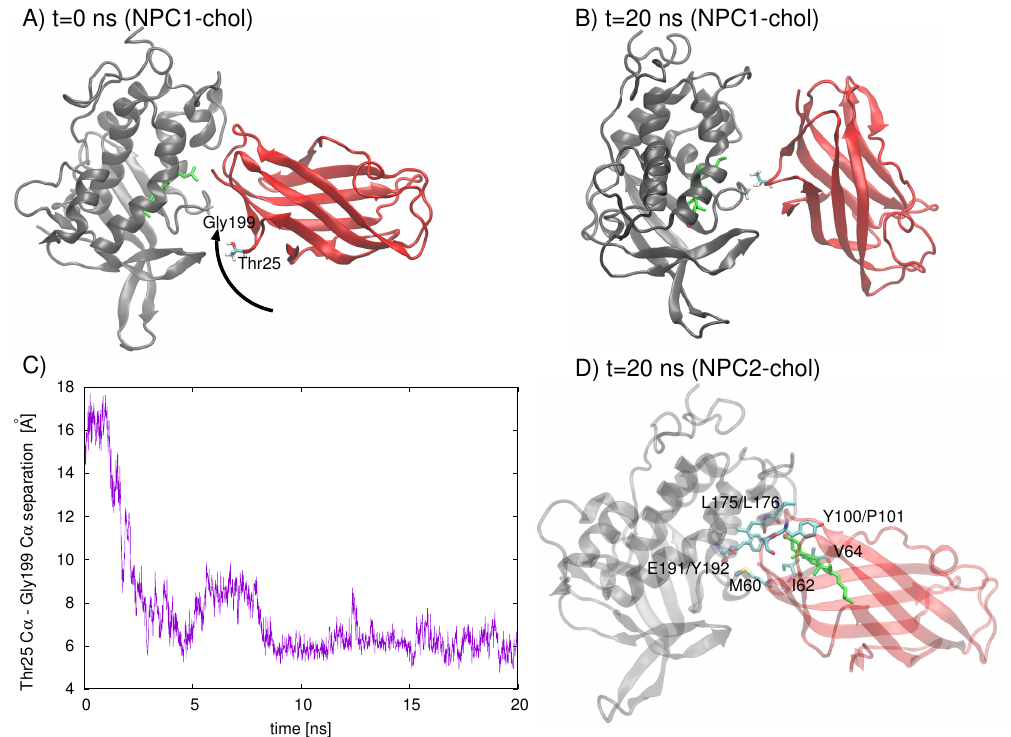
Figure 4. The relative orientation of the Texas model NPC1(NTD)-NP2 subunits with cholesterol in the NPC1 binding pocket (gray cartoon representation) at ( A ) t = 0 ns and ( B ) t = 20 ns highlights the rotation of the subunits with respect to each other. ( C ) The rotation brings two protruding loops, with Thr25 of NPC2 (red cartoon representation) and Gly199 of NPC1, into close proximity (Thr25 C α –Gly199C α decreases from ∼ 16 Å to ∼ 6 Å). ( D ) The relative orientation of the Texas model NPC1(NTD)-NP2 subunits (shown here in transparent cartoon representation for clarity) with cholesterol (green stick) in the NPC2 binding pocket at t = 20 ns preserves the interface interactions between NPC1 (L175, L176, E191, Y192) and NPC2 (M60, I62, V64, Y100,